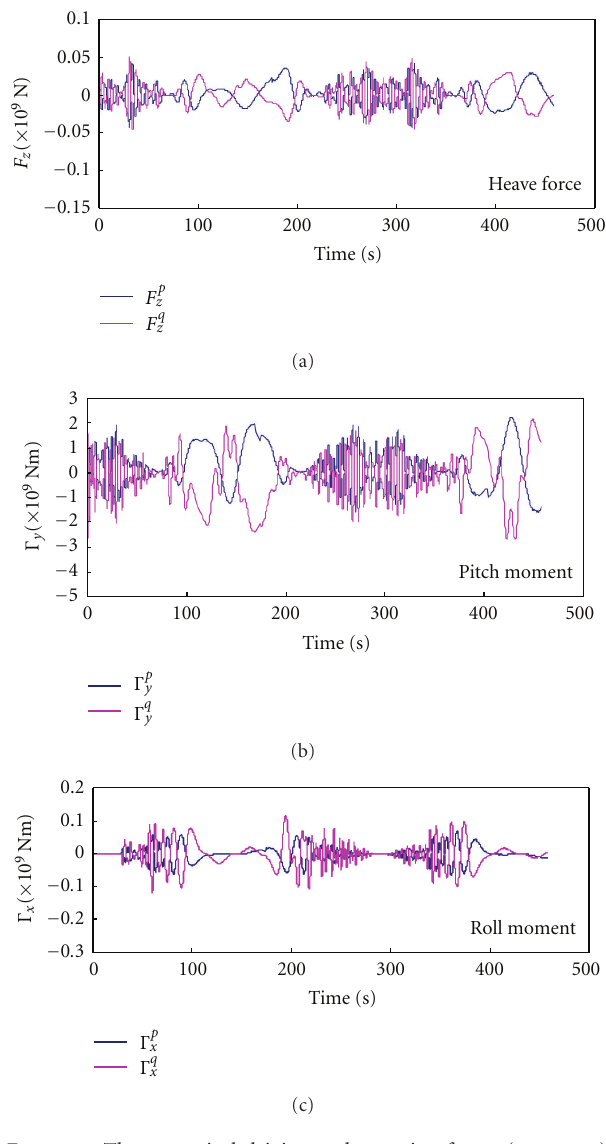
Figure 7: The numerical driving and restoring forces (moments) from the improved DiSSEL for Case 4, but with the irregular incident waves specified in Figure